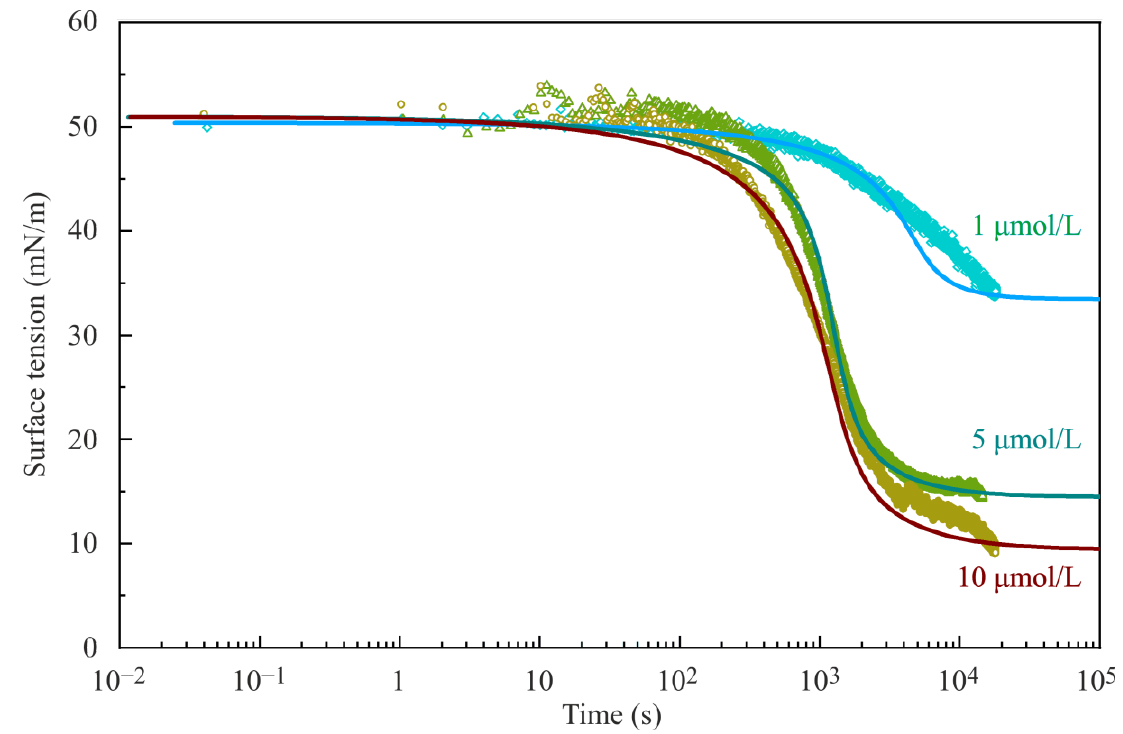
Figure 7. Dynamic interfacial tension of mixed aqueous solutions of NaC 16 SO 4 + C 12 TAB at the water/hexane interface measured by PAT-1; ( (cid:7) ) 1 µ mol/L, ( ) 5 µ mol/L, ( • ) 10 µ mol/L; solid lines are calculated from the Frumkin adsorption model; the same data and the corresponding fitted curves for the reorientation model are shown in the supplement materials.